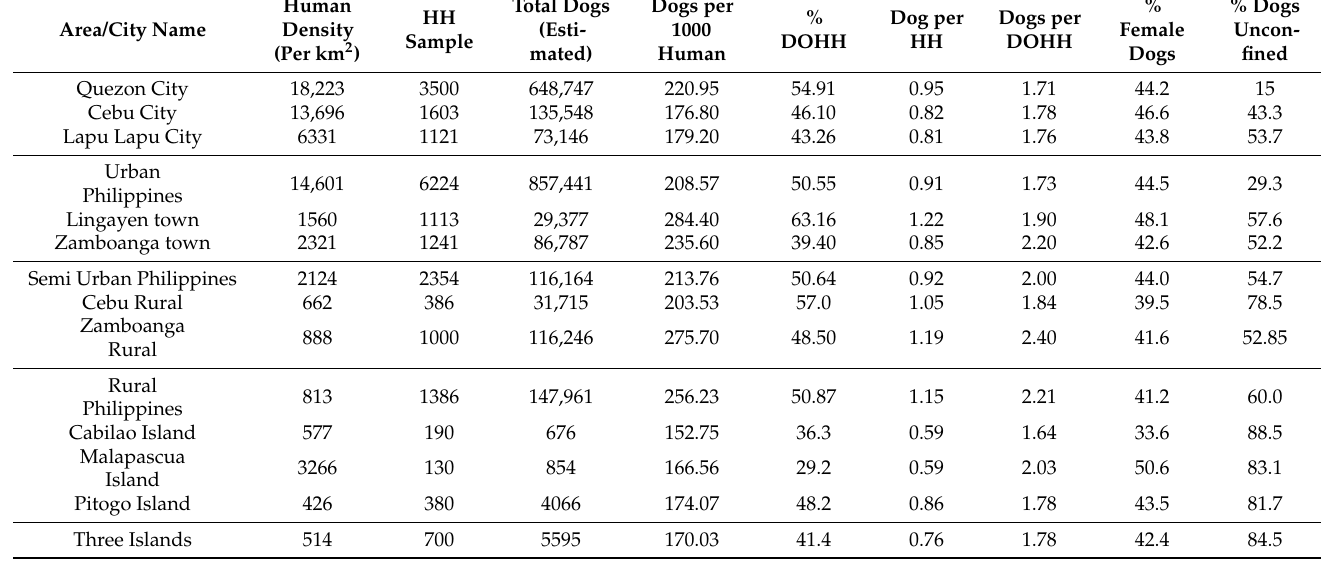
Table 1. Number of households surveyed, dog population estimates, dogs per 1000 humans, per- centage of dog owning households, average number of dogs per household, dogs per dog owning household, percentage of female dogs in the population and percentage of dogs allowed to roam freely for some or all of the day in different locations [DOHH—Dog-owning Household; HH—Household].